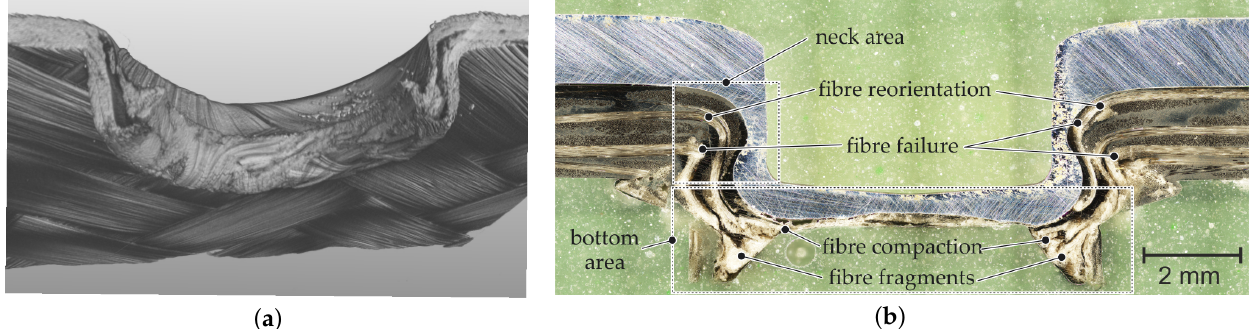
Figure 11. ( a ) CT analysis of the TPC of a Hotclinching joint and ( b ) micrograph of a Hotclinching joint